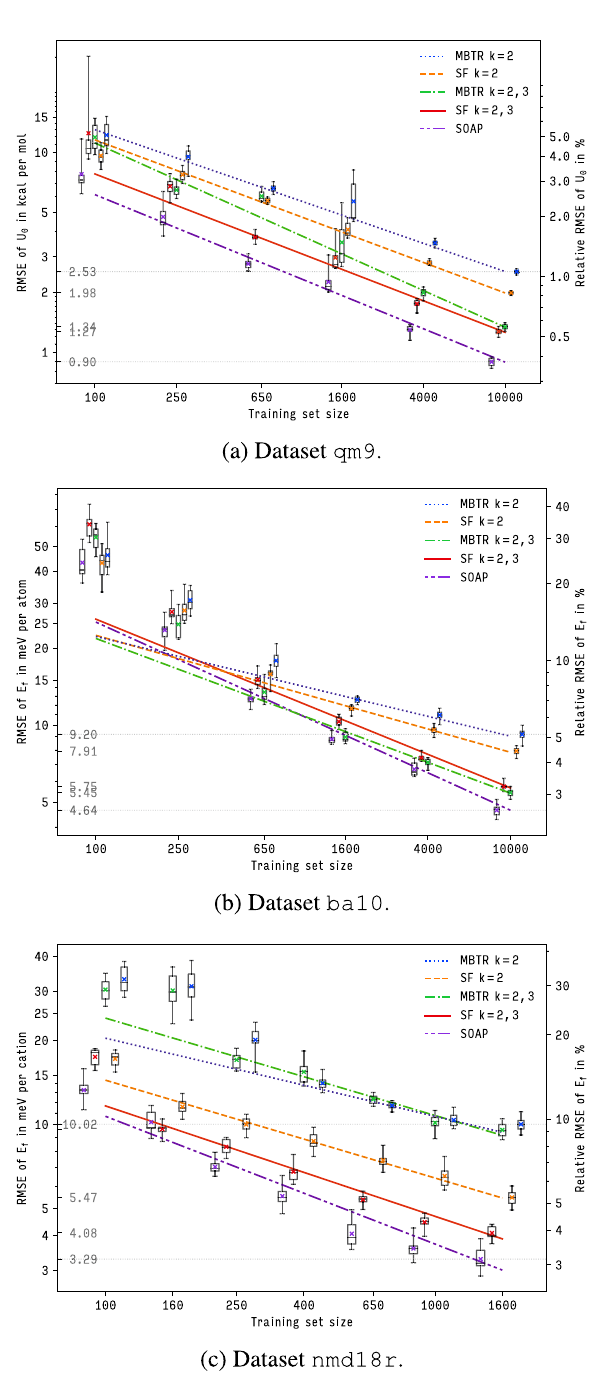
Fig. 5 Learning curves for selected representations on datasets. Datasets a qm9, b ba10, and c nmd18r. Shown is root mean squared error (RMSE) of energy predictions on out-of-sample-data as a function of training set size. Boxes, whiskers, bars, crosses show interquartile range, total range, median, mean, respectively. Lines are fi ts to theoretical asymptotic RMSE. (Supplementary Note16). See Glossary (Table 1) for